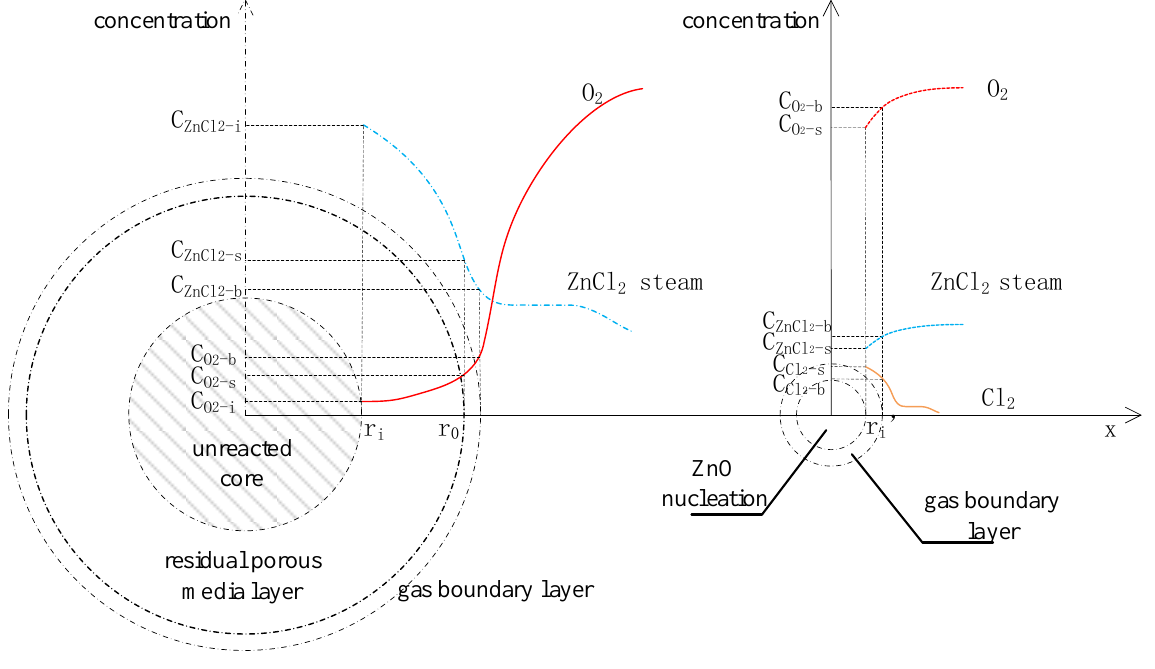
Figure 8: Reaction mechanism model of dechlorination and [Zn] reclaiming in the roasting steelmaking zinc-rich dust process